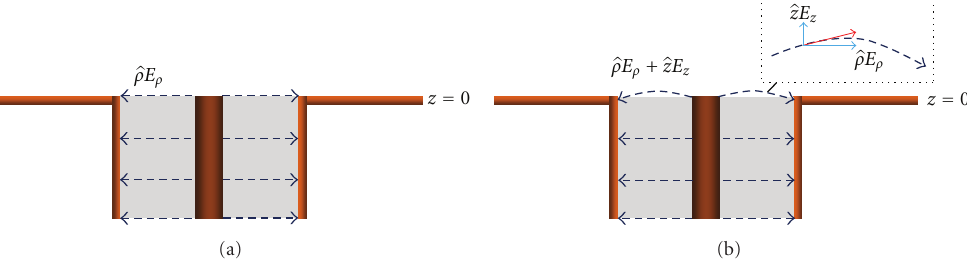
Figure 1: Propagated wave from coaxial line ( z < 0) into free space ( z > 0) through the ground plane ( z =